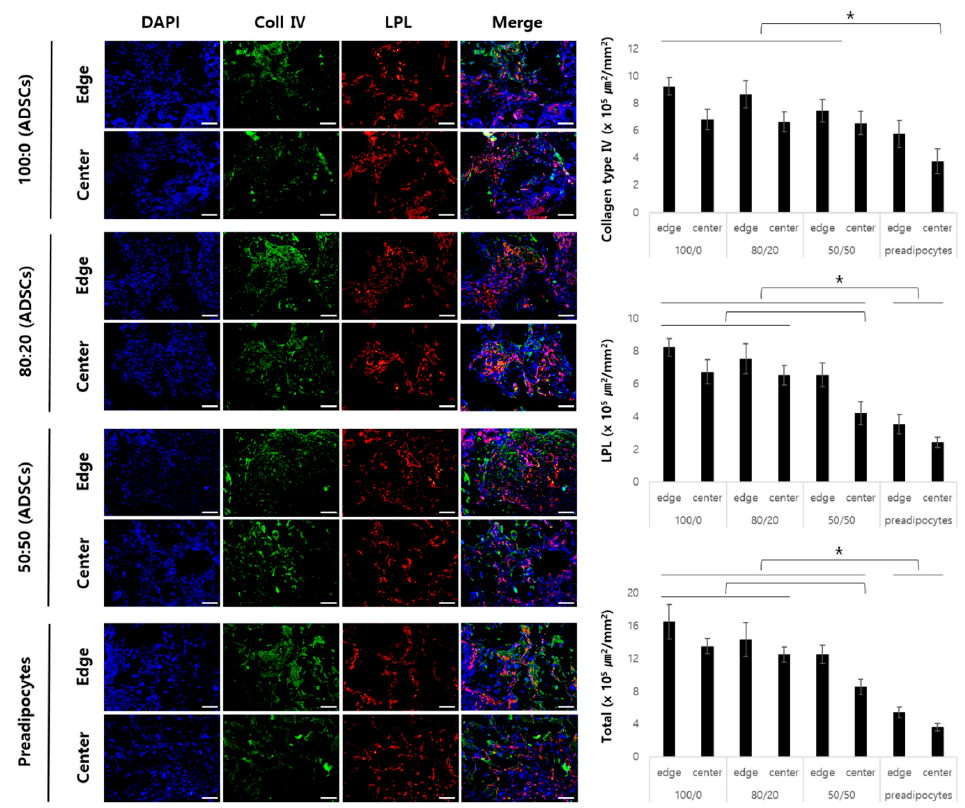
Figure 7. Immunofluorescence staining adipogenic markers for each group of the 12-week in vivo samples. Scale bar: 100 μ m (* p <